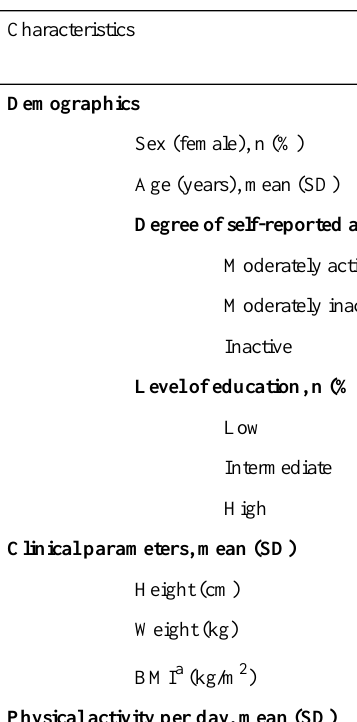
Table 1. Baseline characteristics of 235 study